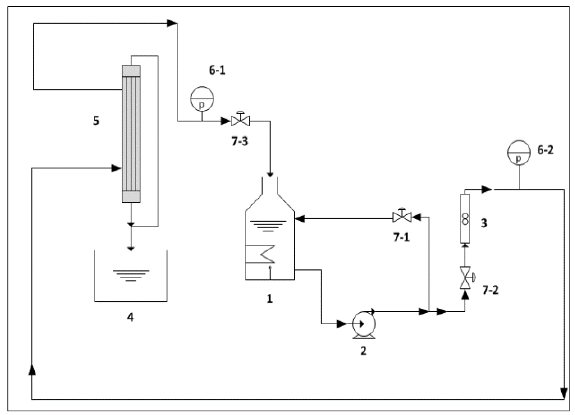
Fig. 1 . Schematic diagram of the UF membrane experimental unit; 1: Feed tank, 2: Pump, 3: Flow meter, 4: Permeate tank, 5: Hollow fiber module, 6- 1, 2: Gauge pressure, 7-1, 2, 3: